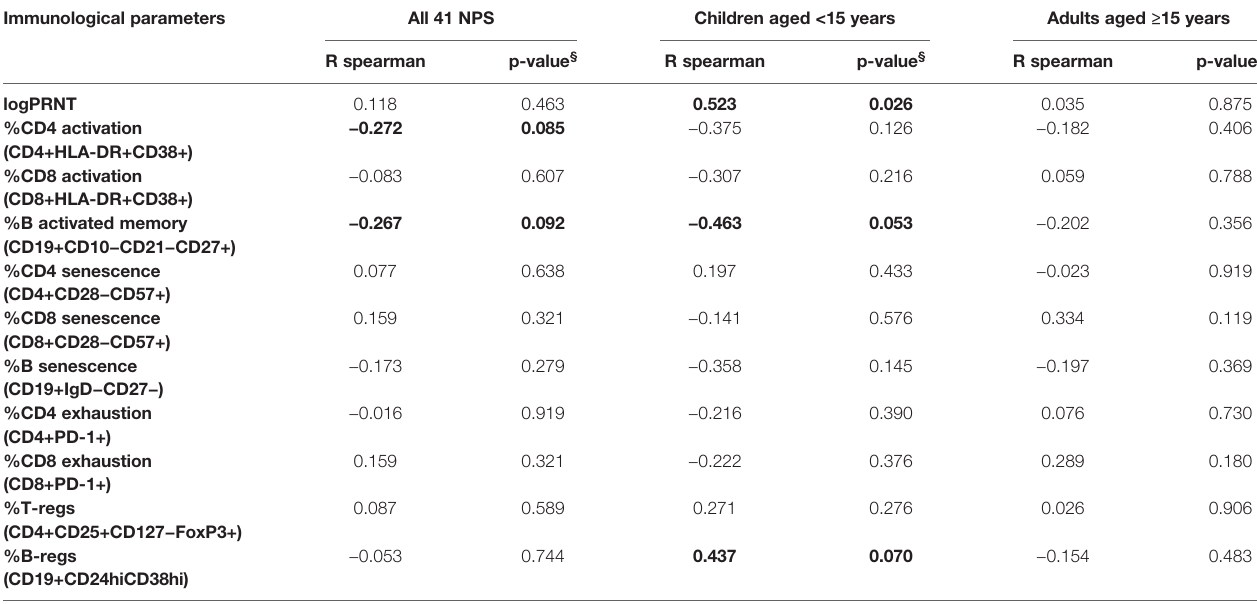
§ Spearman correlation. Bold values refer to R spearman and p-values that are or tended to be signi fi